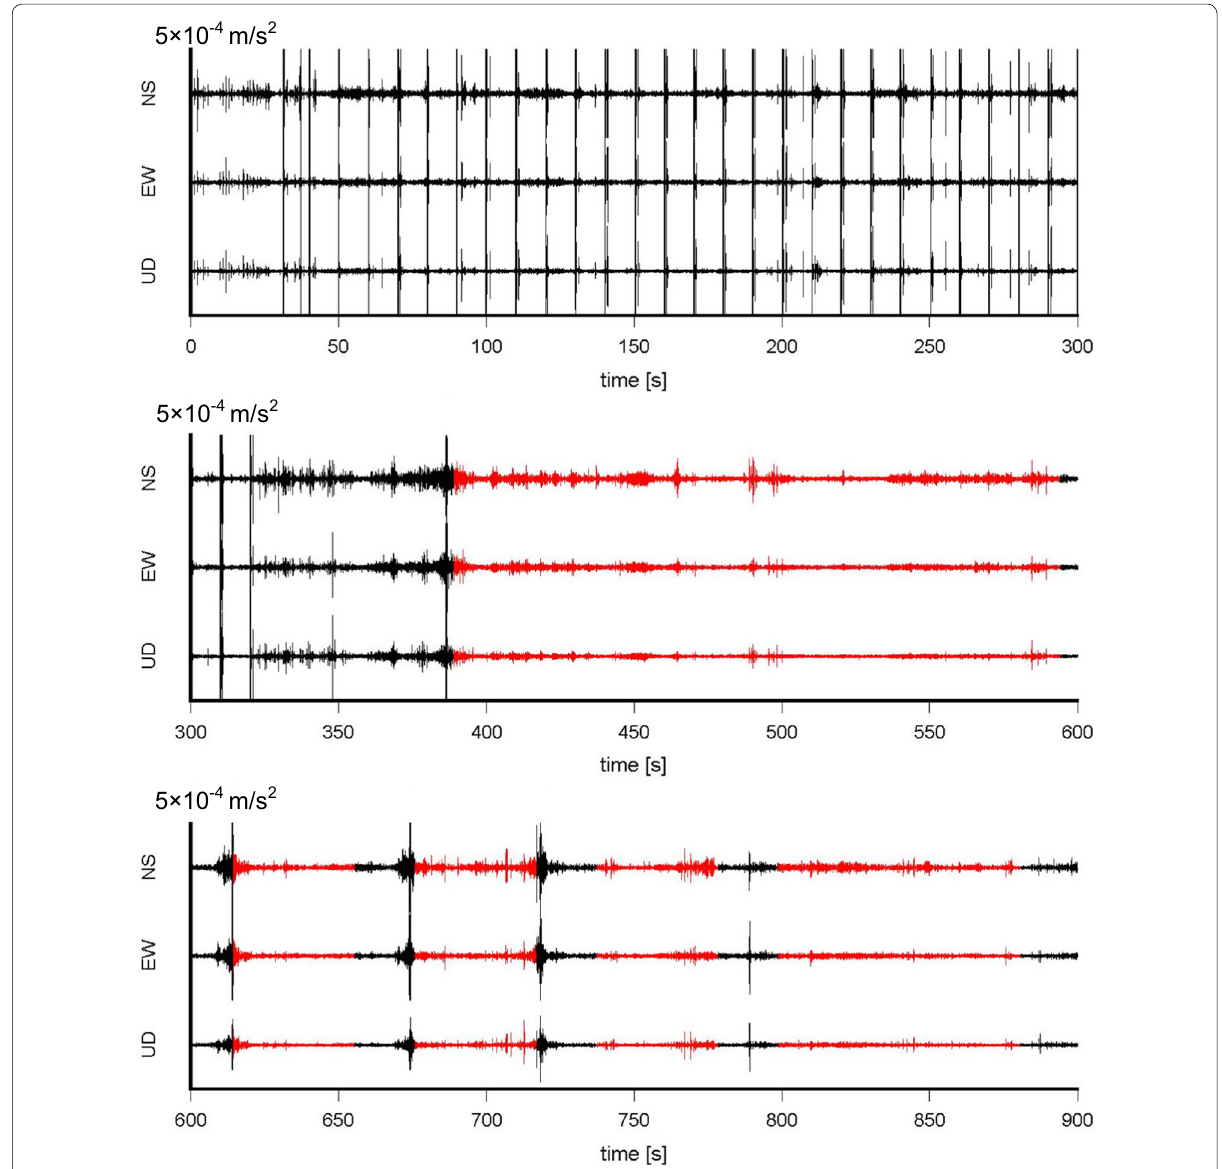
Fig. 4 Measured microtremor waveform at a measurement point EHM012. Red lines indicate parts used for